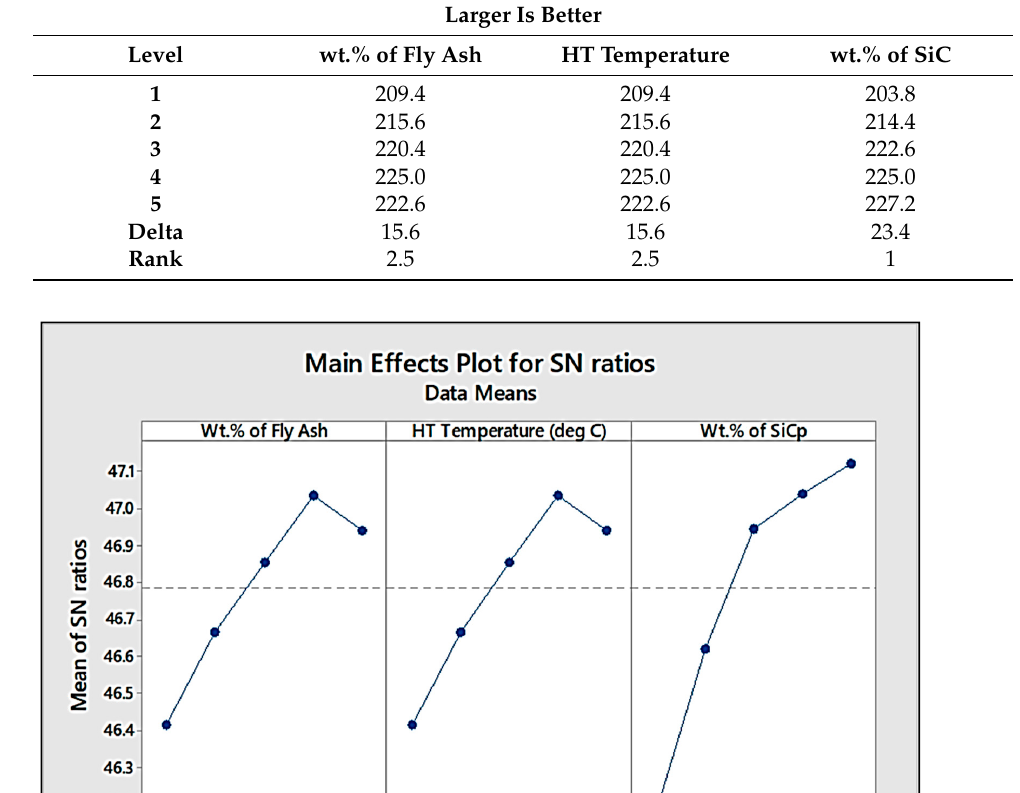
Table 7. Response table for means for ultimate tensile strength.